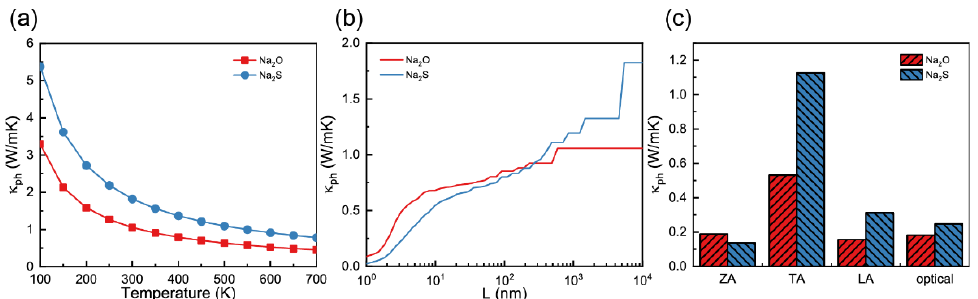
Figure 3. ( a ) The thermal conductivity of Na 2 O and Na 2 S monolayers as a function of temperature. ( b ) The mean free path dependence of the thermal conductivity for Na 2 O and Na 2 S monolayers at room temperature. ( c ) The thermal conductivity at room temperature contributed from ZA, TA, LA, and optical modes.